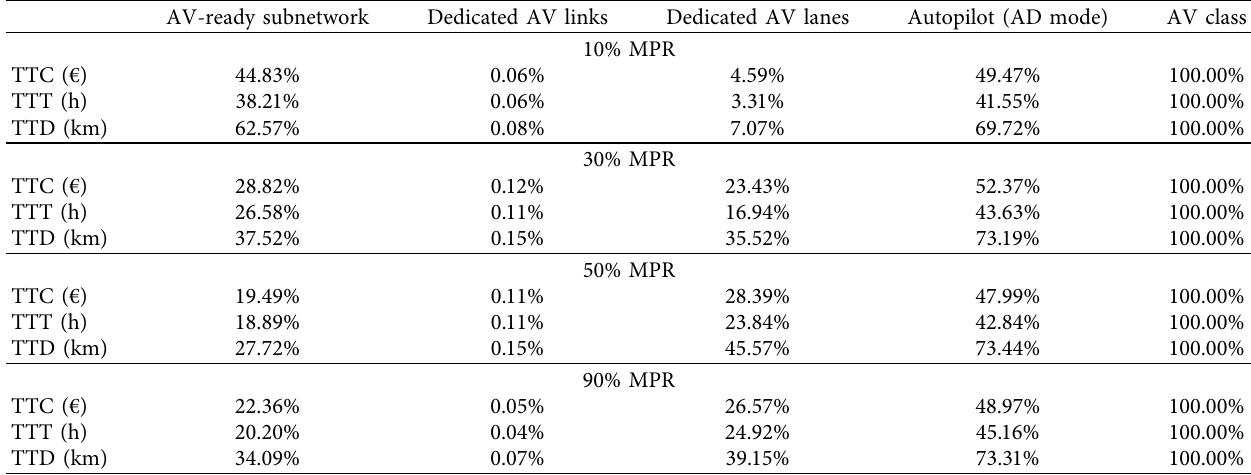
Table 5: Network performance indicators for the AV class in all subnetworks (indexing is based on AV class column).